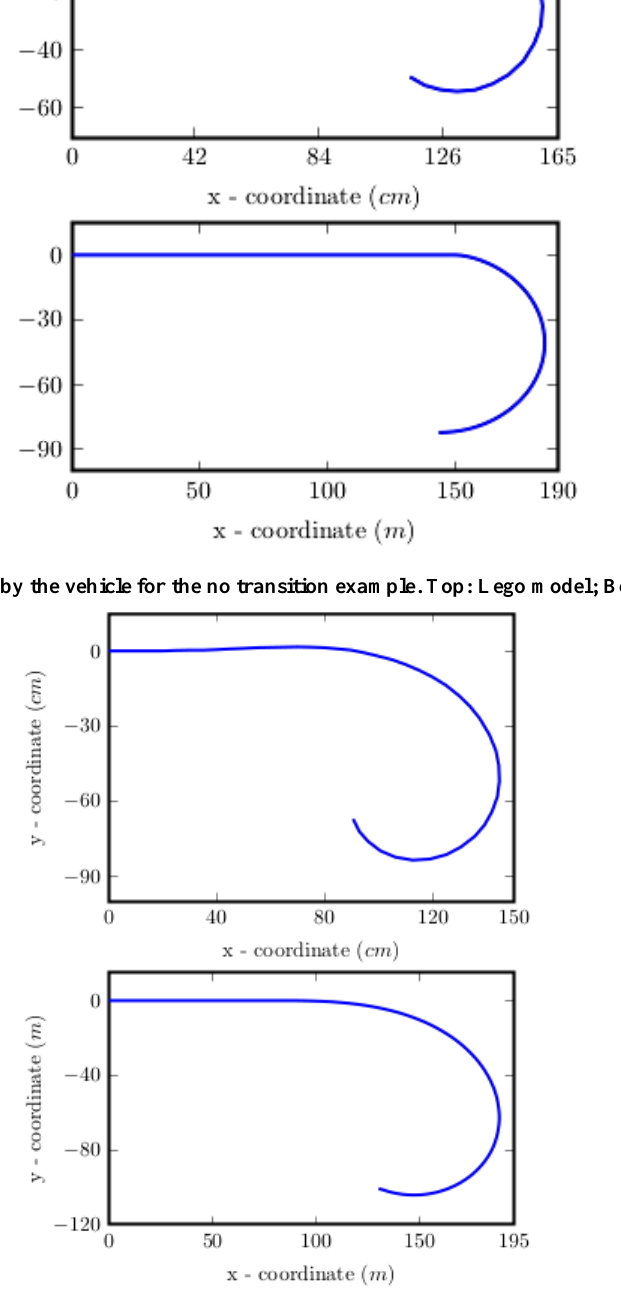
Figure 13. The path traced by the vehicle for the clothoid example. Top: Lego model; Bottom: Blender